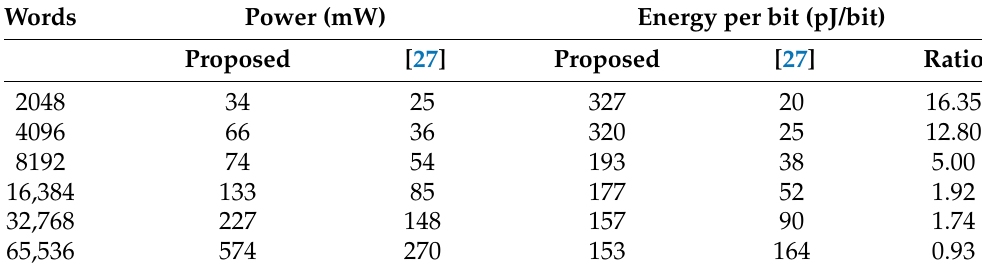
Table 4. Power and energy—Word width = 64